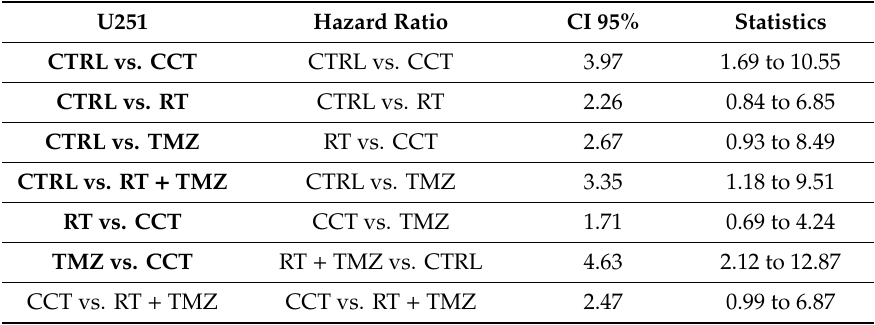
Table 6. Summarized statistical data from the Kaplan Meier curves presented in Figure